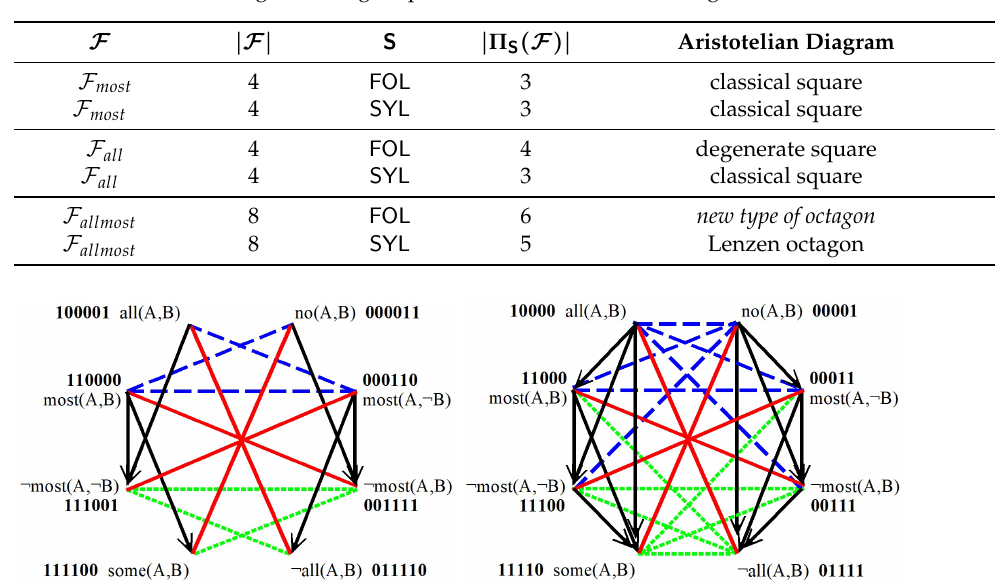
Table 1. Overview of fragments, logics, partitions and Aristotelian diagrams.